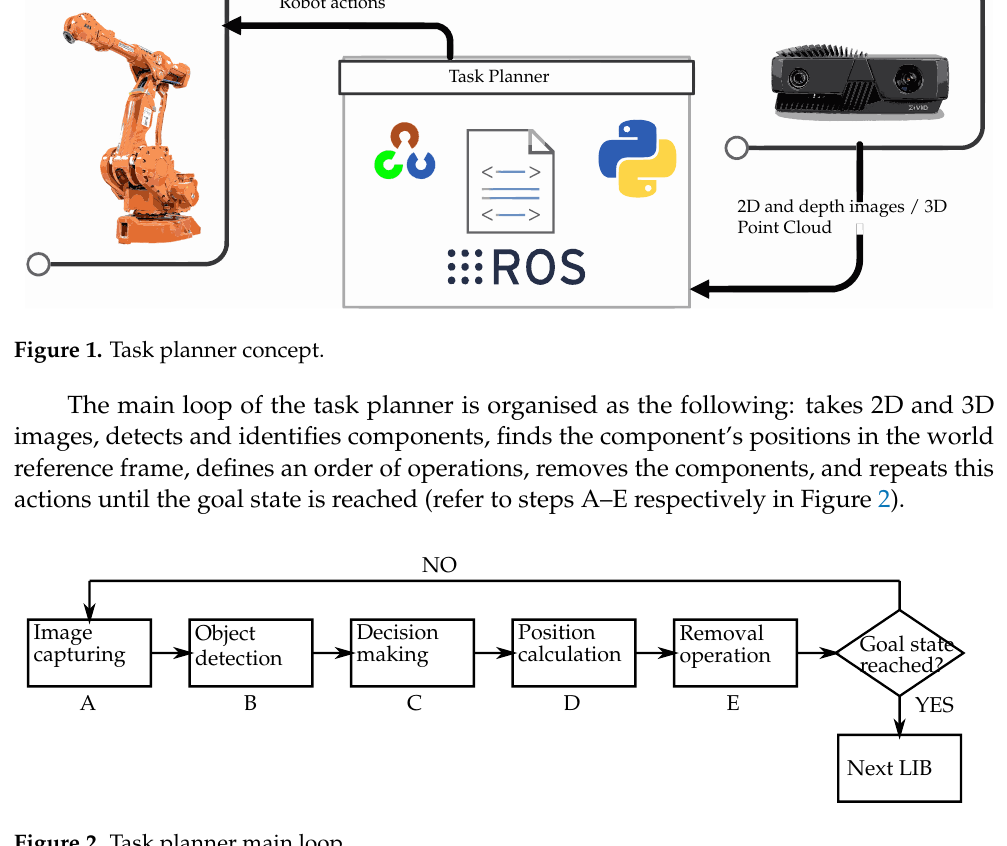
Figure 2. Task planner main loop